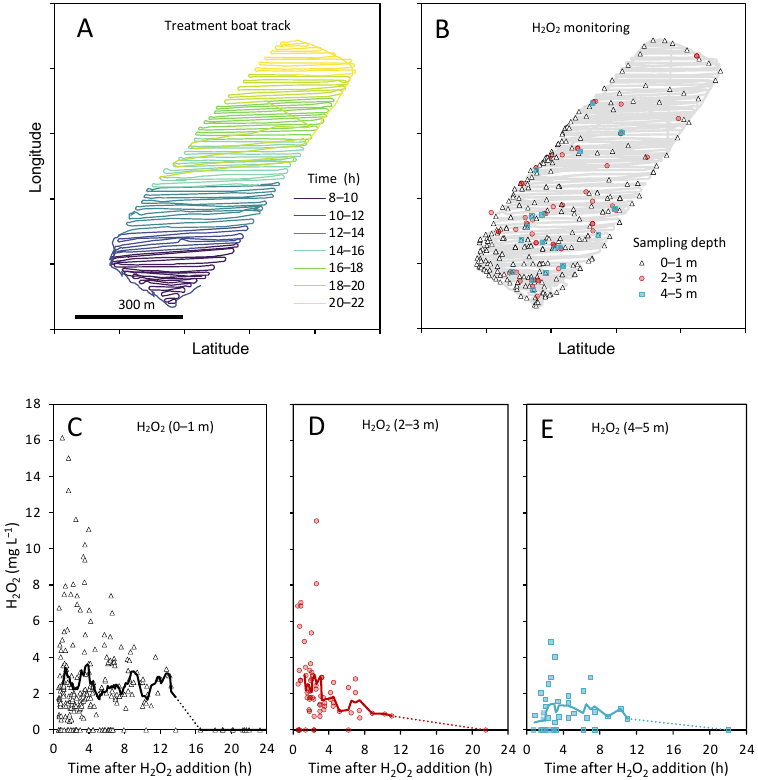
Figure 2. H 2 O 2 treatment of the lake. The graph shows ( A ) the boat track during the treatment in August, ( B ) the sampling locations and the sampling depth where H 2 O 2 concentrations were monitored during the treatment. ( C – E ) H 2 O 2 concentrations measured at different time points after the treatment boat had passed the sampling locations, ( C ) at 0–1-m depth, ( D ) at 2–3-m depth and ( E ) at the 4–5-m depth. Colors in panel ( A ) indicate the time of day during which a certain section of the lake was treated; different symbols in panel ( B ) indicate the sampling depth; lines in panels ( C – E ) are moving averages with a window size of 60